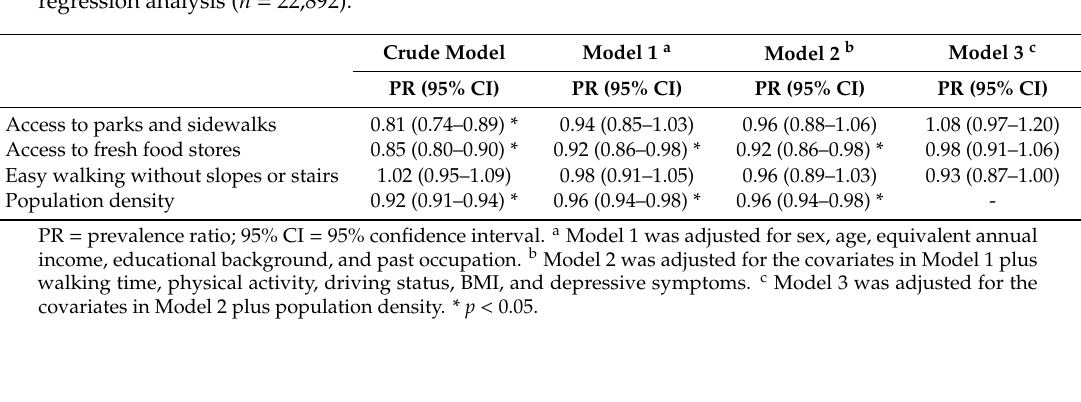
Table 4. Association between neighborhood walkability and low back pain by multilevel Poisson regression analysis ( n =